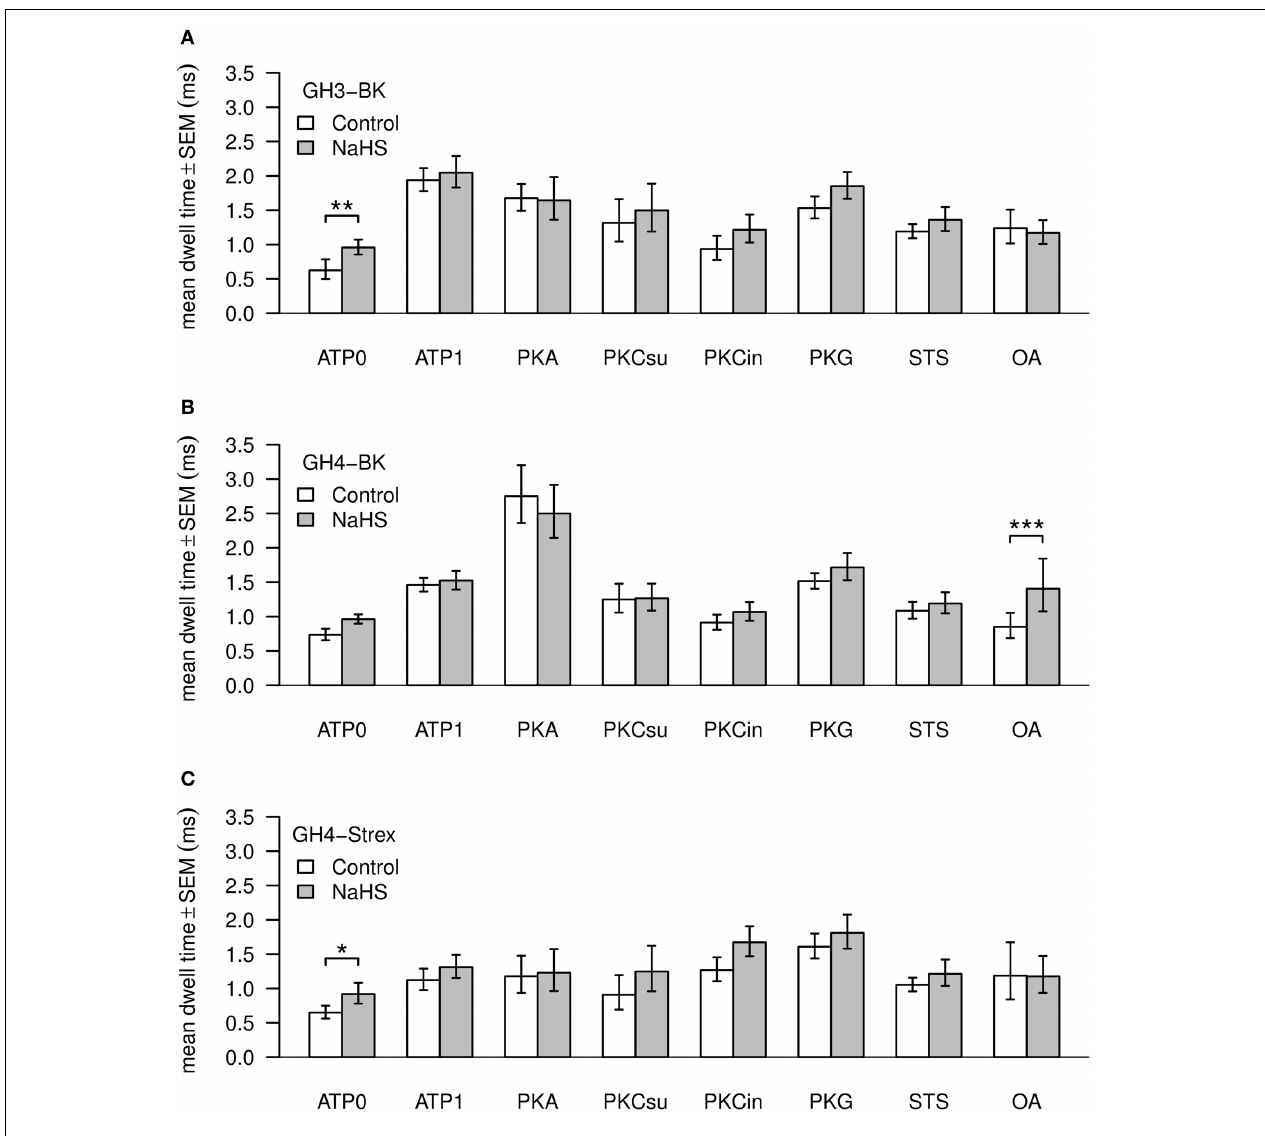
FIGURE 4 | Mean values of BK channel open dwell times. Three types of channels—GH3-BK (A) , GH4-BK (B) , and GH4-STREX (C) cells were investigated. Bar graphs show open dwell values in ms under control conditions (left bars, white) and after